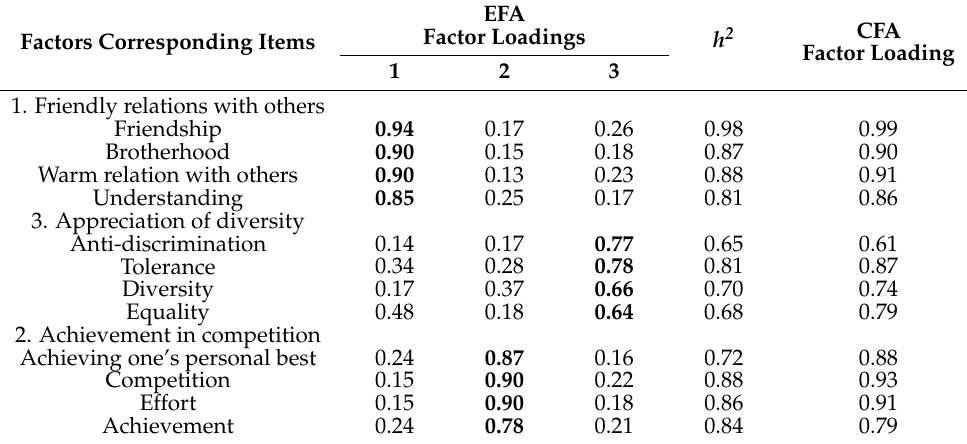
Table 2. Factor loadings and communalities (h 2 ) for the LT-OVS in the EFA ( n = 182) and in the